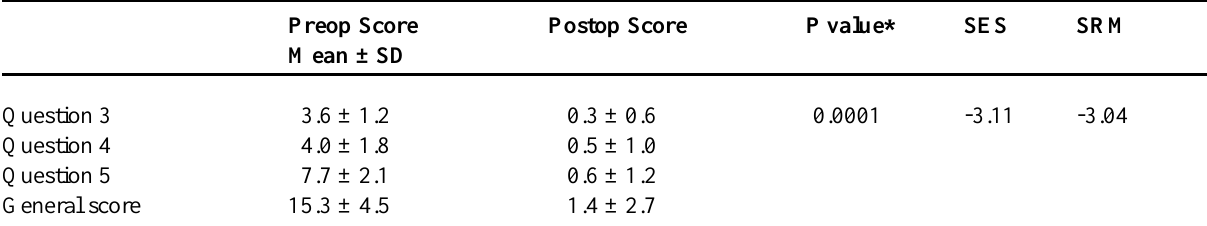
Table 2 – Comparison between pre and postoperative scores of the ICIQ-SF and internal responsiveness study